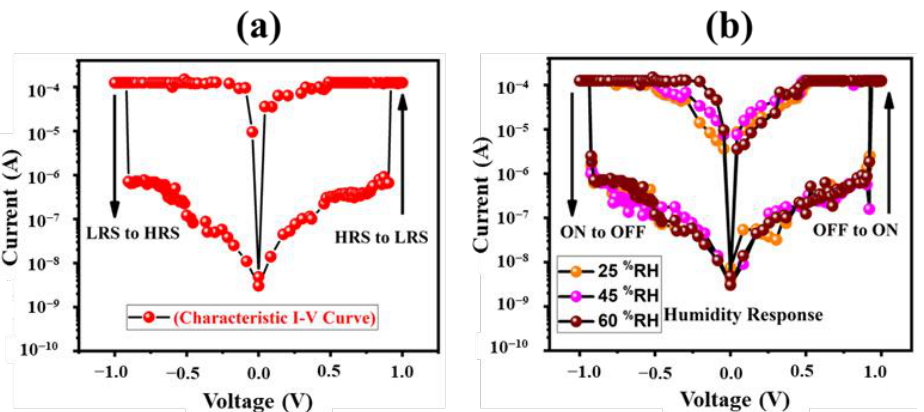
Figure 4. Electrical characteristics of metal–non-metal-doped TiO 2 based memristor. ( a ) Signature graph of memristor showing its bipolar resistive switching behavior in the operating voltage range of ± 1 V. ( b ) Effect on electrical characteristics of flexible memristor under the varying relative humidity levels of 25%, 45% and 60%, respectively.